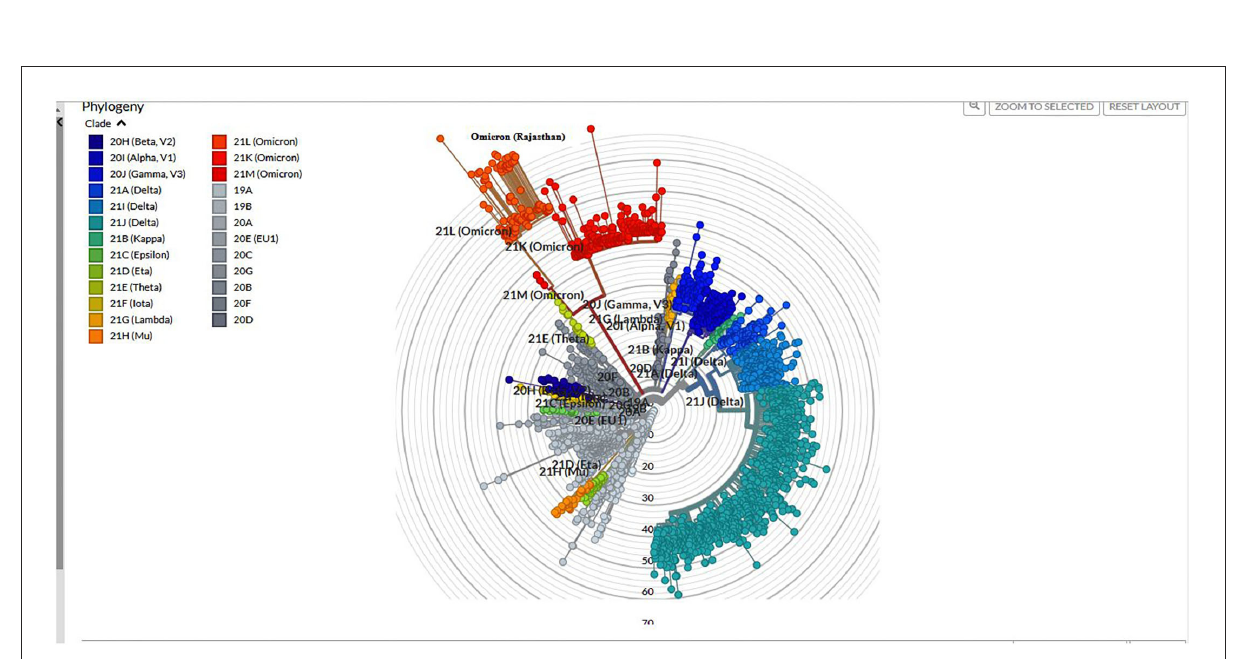
FIGURE3 Phylogenetic tree of Omicron built using the Nextclade online